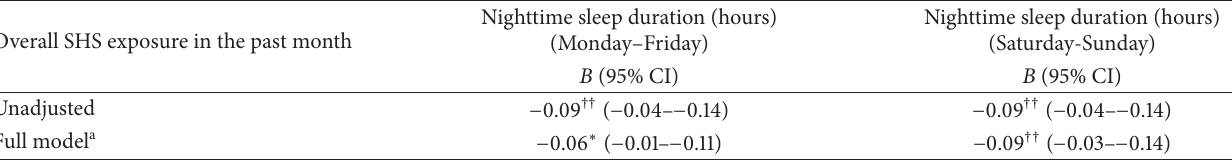
Overall SHS exposure in the past